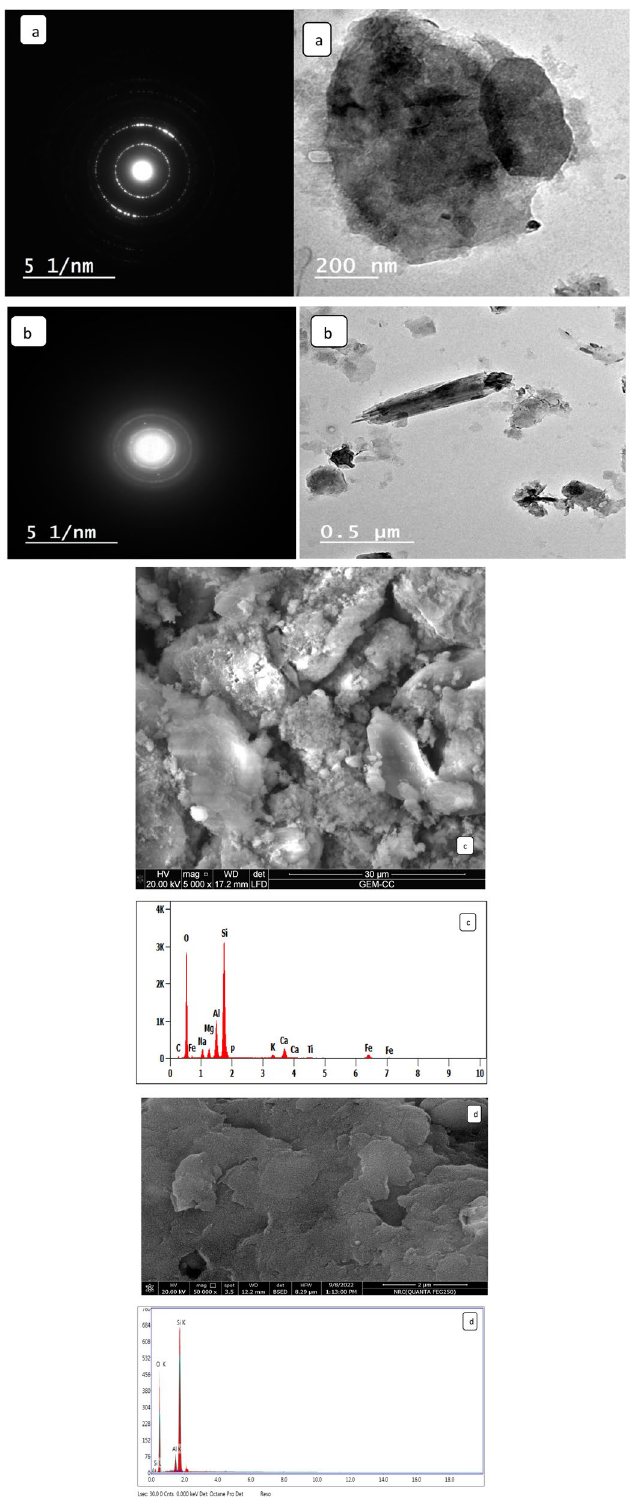
Fig. 5 TEM a nano-bentonite, b MgO impregnated clay, and SEM images and Energy dispersive X-ray analysis, c raw bentonite, d nano-bentonite within EDX, e MgO impregnated clay within EDX, f nano-bentonite after adsorption MG, g MgO impregnated clay after adsorption MG and h after adsorption MG by fungi low and high magnification,